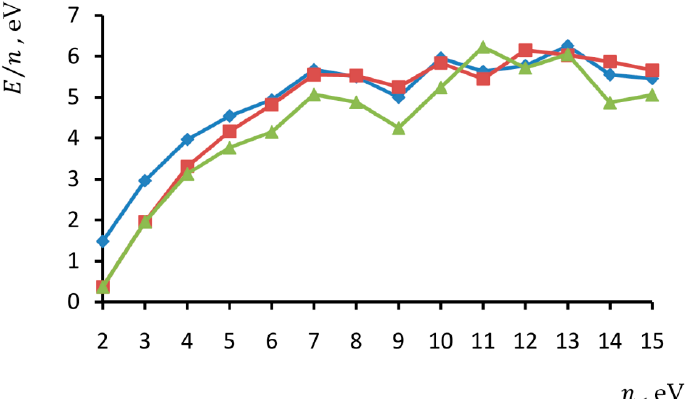
(cid:4) Figure 2. Specific binding energy of neutral ( ♦ ), positively ( ■ ) and negatively ( ▲ ) charged boron Figure 2. Specific binding energy of neutral ( ), positively ( (cid:4) ) and negatively ( (cid:78) ) charged boron small planar clusters in dependence on number of atoms calculated in diatomic model. small planar clusters in dependence on number of atoms calculated in diatomic